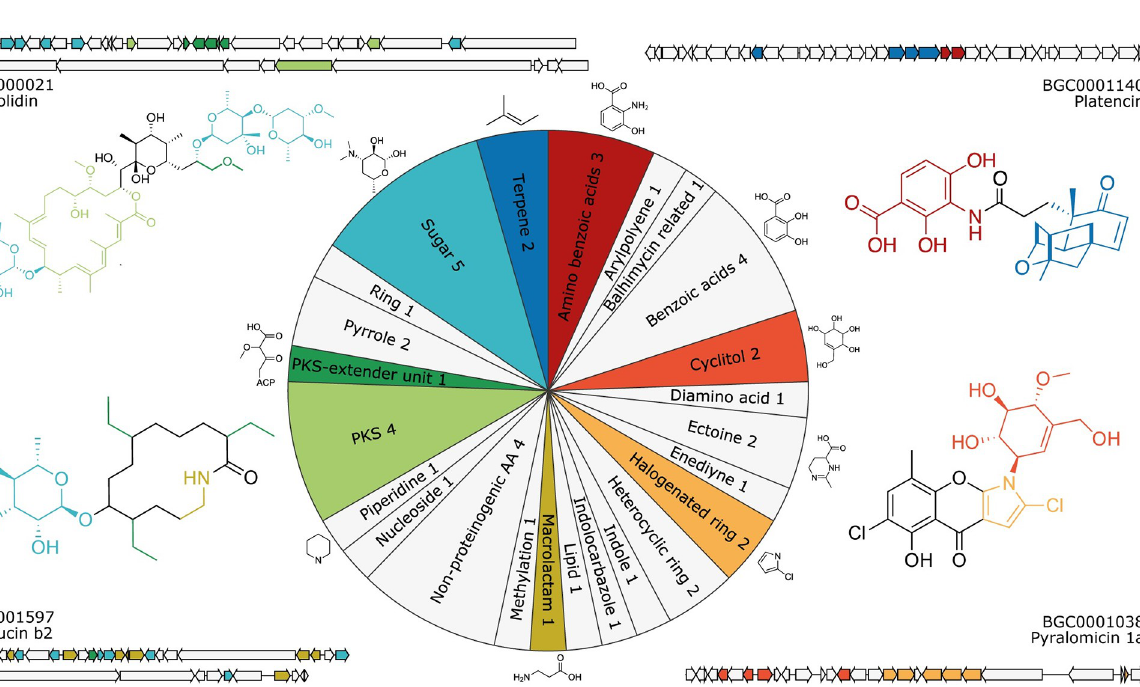
Fig 3. Sub-cluster motif annotations. The pie chart visualises the annotations for the 45 sub-cluster motifs divided into general substructure groups, where an example substructure is shown for several groups. Additionally, examples of eight of the substructures are shown in the structures of apoptolidin, platencin, fluvirucin b2 and pyralomicin 1a, where the colours of the substructures correspond to the sub-cluster motif annotations in the pie chart. For these four metabolites, their respective BGCs are shown where the sub-cluster motifs are highlighted in the same colour as the substructures they